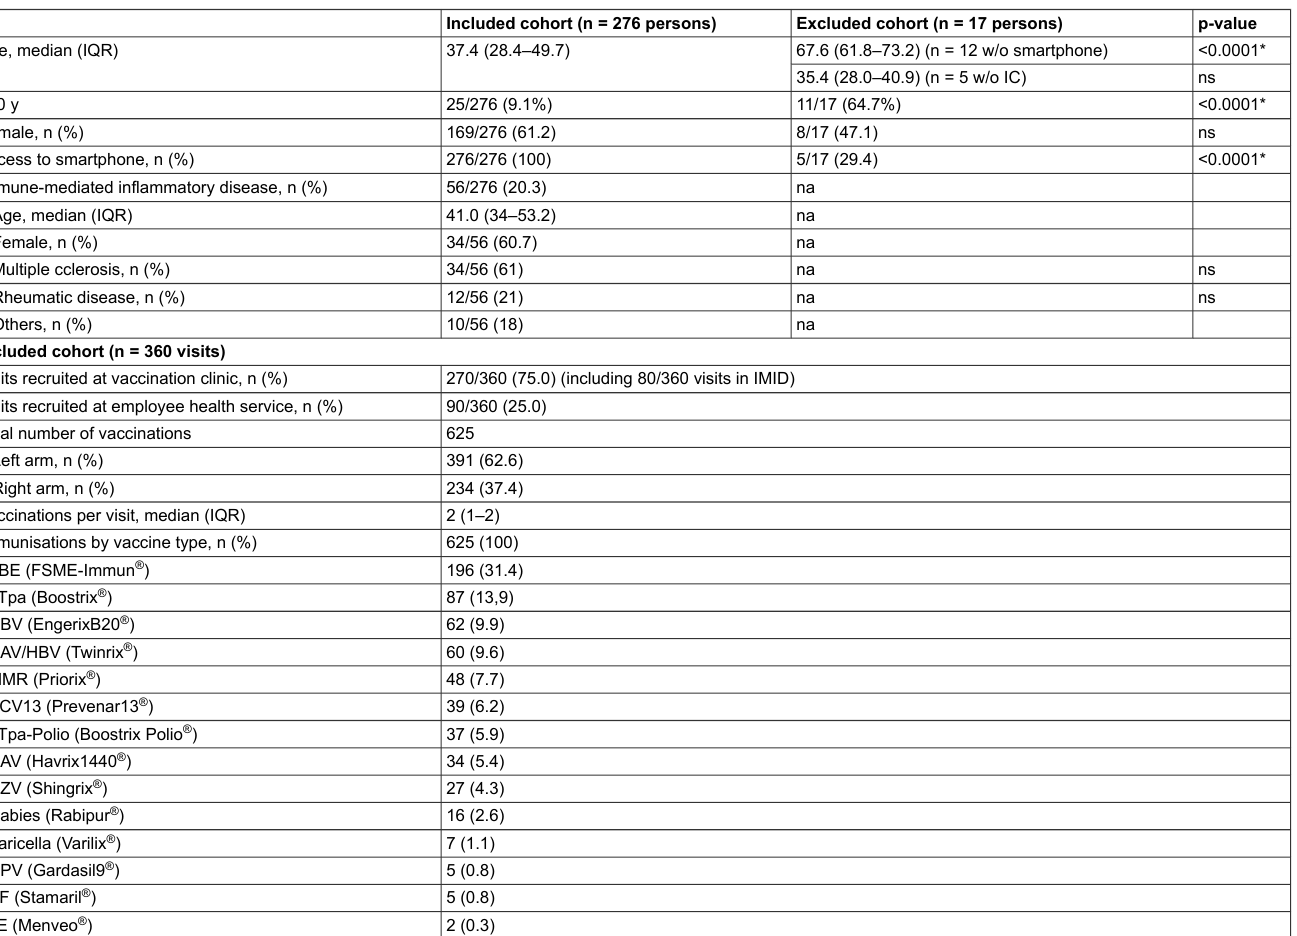
Table 1: Baseline characteristics.